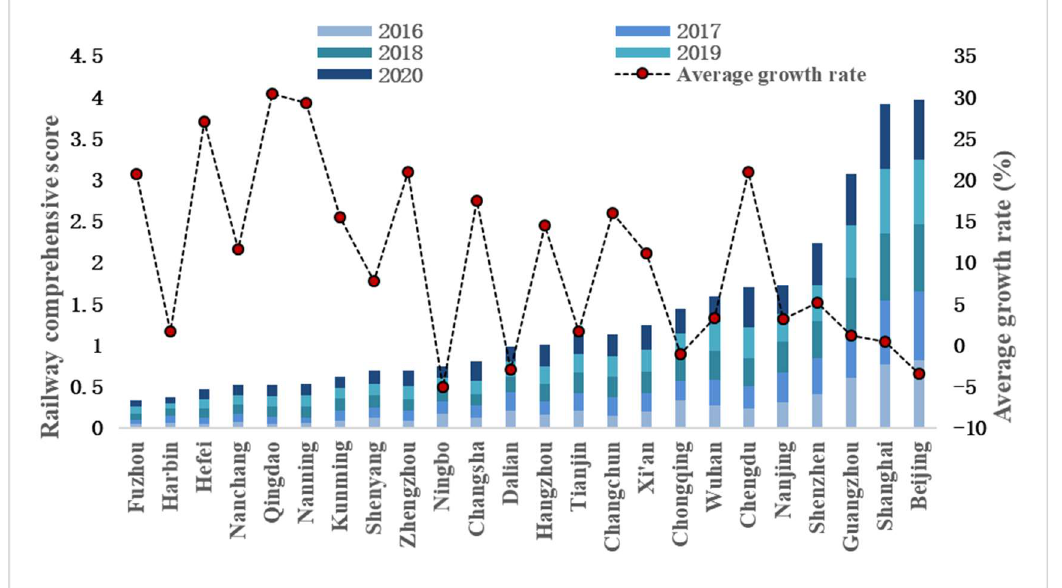
Figure 3. Changes in the comprehensive development level of rail transit in 24 cities in